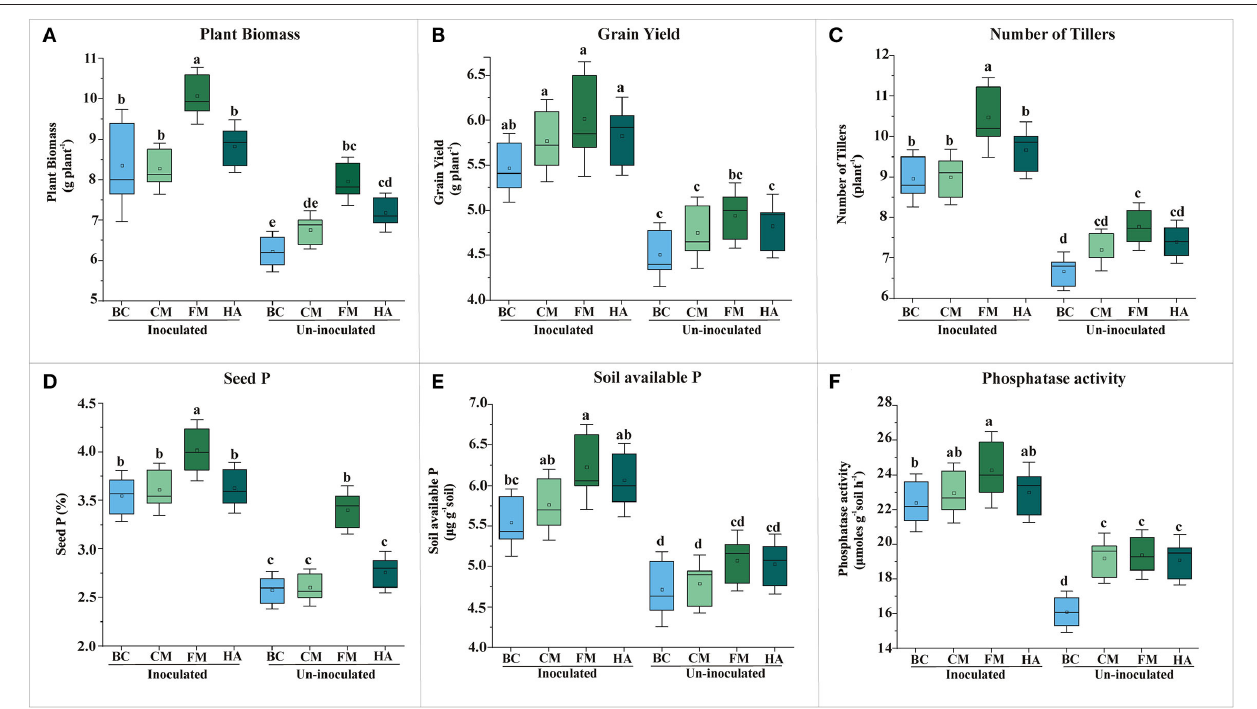
FIGURE 5 | Evaluation of PSB bioformulations for plant yield and soil P contents of wheat grown soil compared to un-inoculated controls. The effect of bioformulation on plant biomass (A) , grain yield (B) , number of tillers (C) , seed P (D) , available P of soil (E) , and phosphatase activity (F) . The mean values are an average of six biological replicates organized in completely randomized design. The mean values followed by different letters are significantly different at p = 0.05. BC, Biochar; CM, Compost; FM, Filter mud; HA, Humic acid.